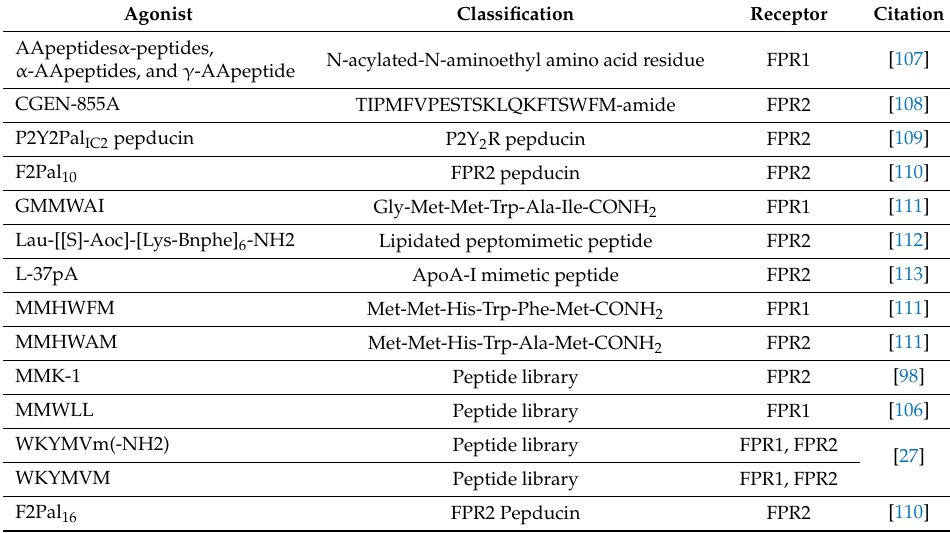
Table 5. Synthetic peptide ligands for FPRs